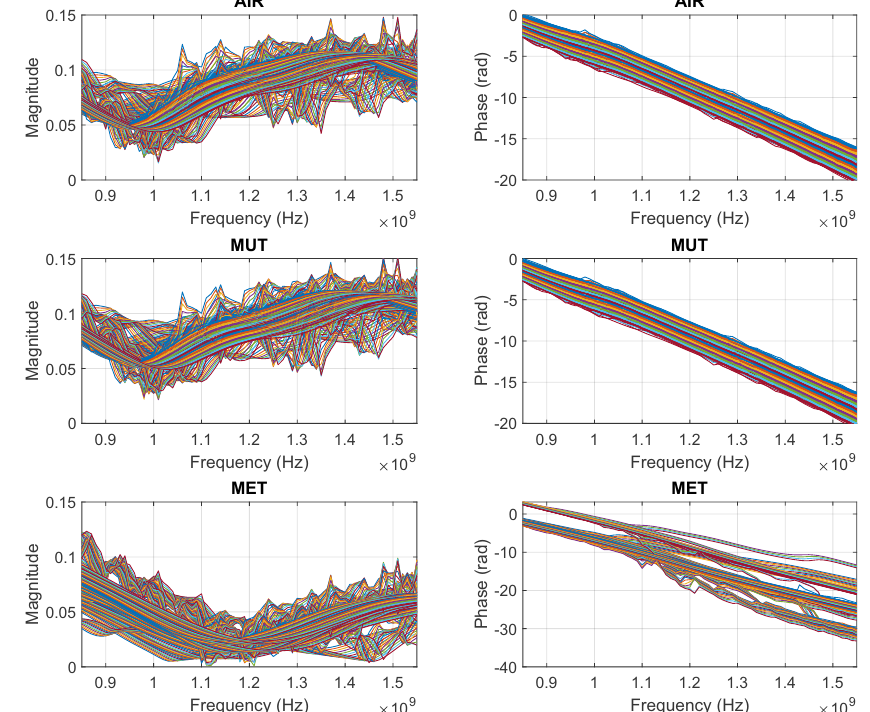
Figure 8. Simulated complex signals for the three configurations, when changing the variable complex ε r of the floor and the probes in a total of 336 curves. Magnitudes are on the left and phases are on the right. From top to bottom we have AIR, MUT and MET. Due to the number of curves, the phase is unwrapped [1,29] for clarity, and the parameter w 0 is kept constant, equal to